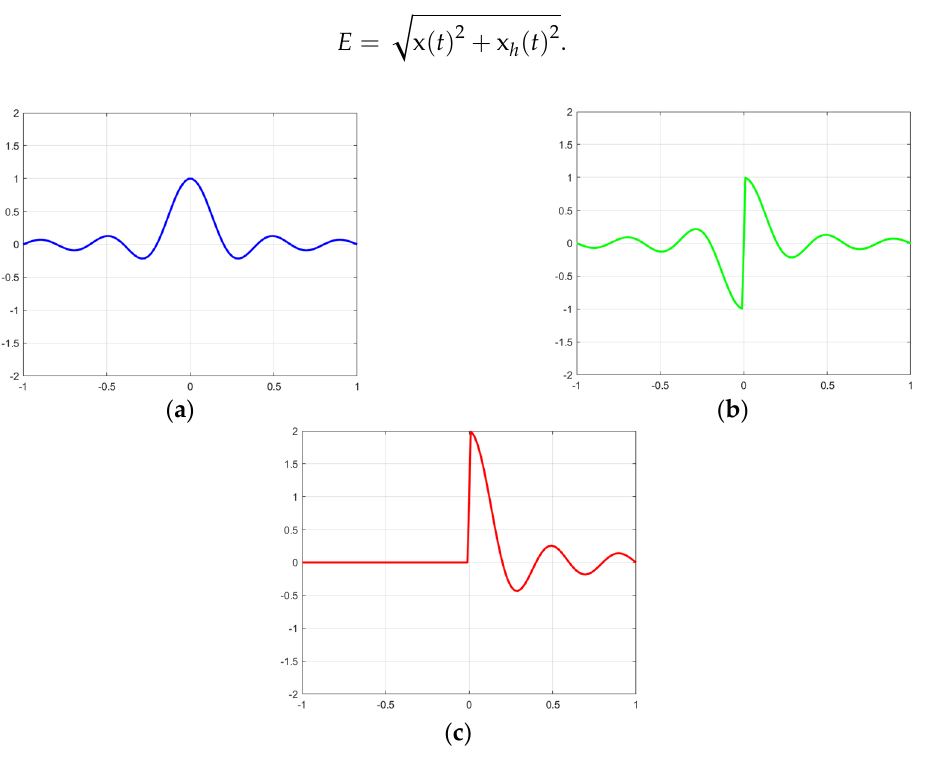
Figure 1. Frequency spectra of ( a ) an original time-varying signal, ( b ) the Hilbert transform of the original signal, and ( c ) the analytic form of the original signal.